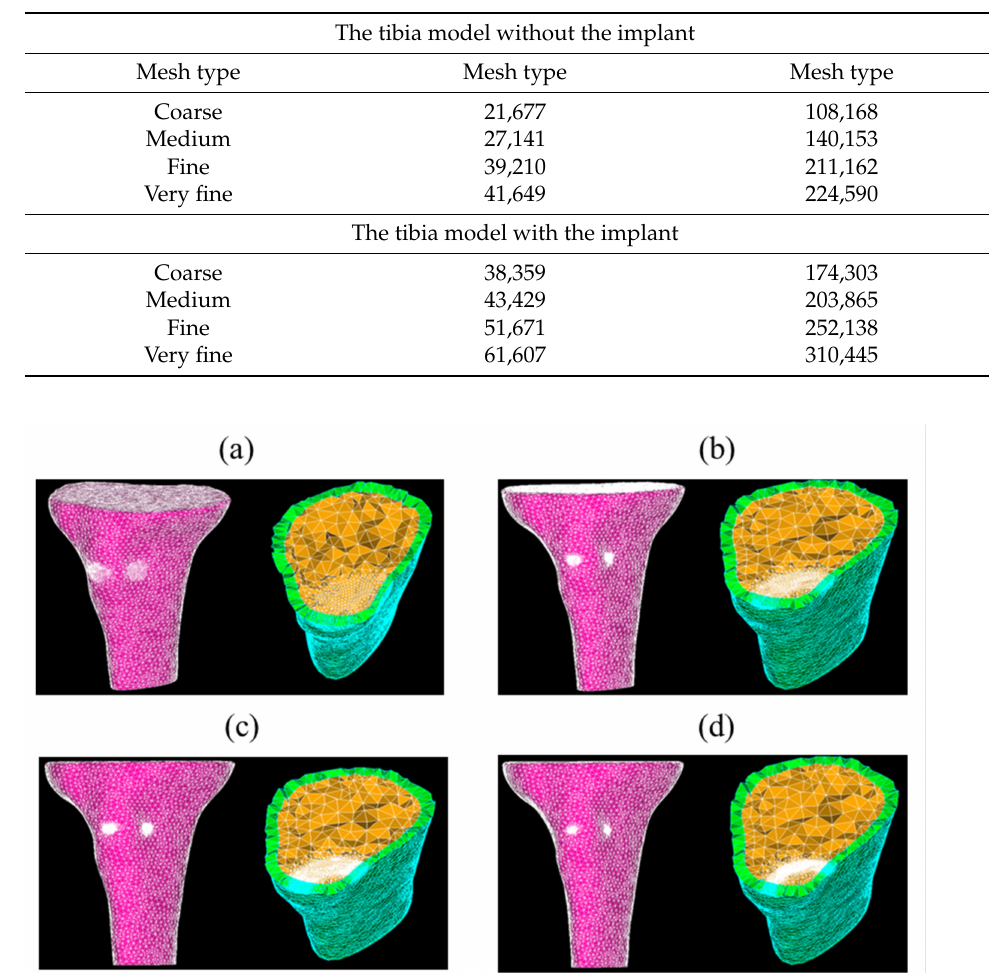
Figure 5. Four meshes of the tibia model without implant—coarse ( a ), medium ( b ), fine ( c ), and very fine ( d )